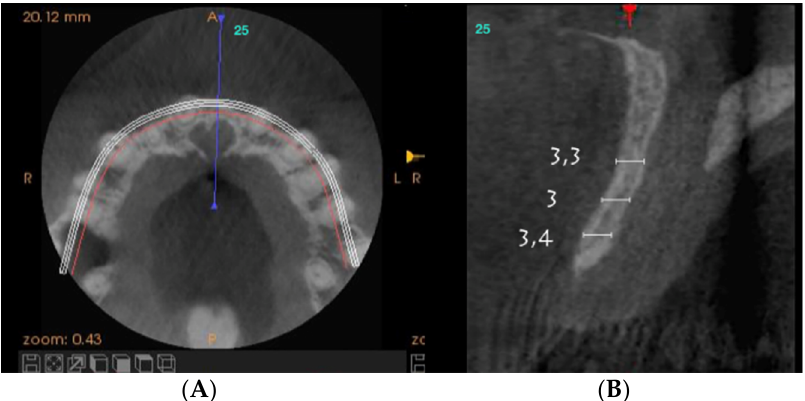
Figure 2. Representative sections of a Cone Beam Computed Tomography (CBCT) scan in which the bone thickness of the maxillofacial region and the widening of the incisive foramen are observed. ( A ) Occlusal view. ( B ) Sagittal view.